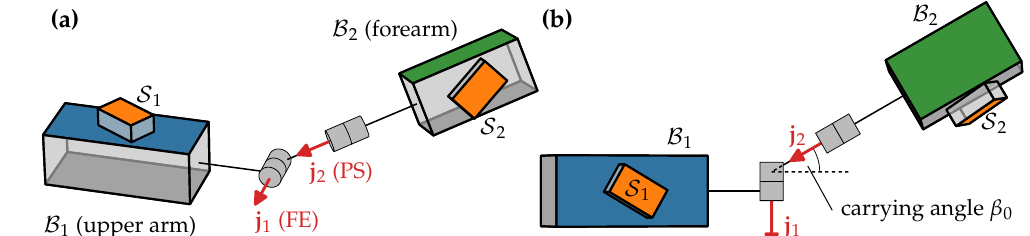
and are placed in S 1 S 2 and forearm . Upper arm and forearm are connected by B 1 B 2